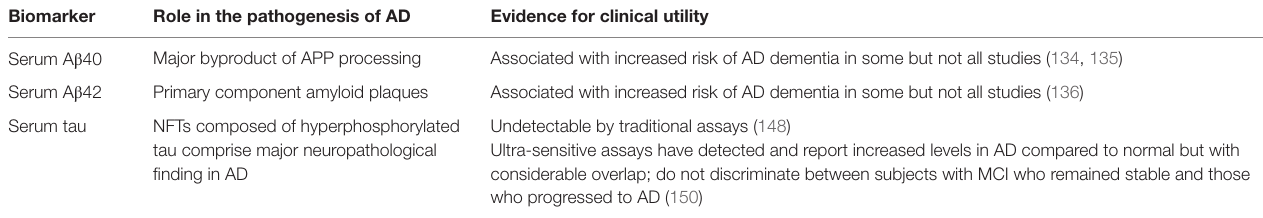
TABLe 2 | Candidate non-CSF